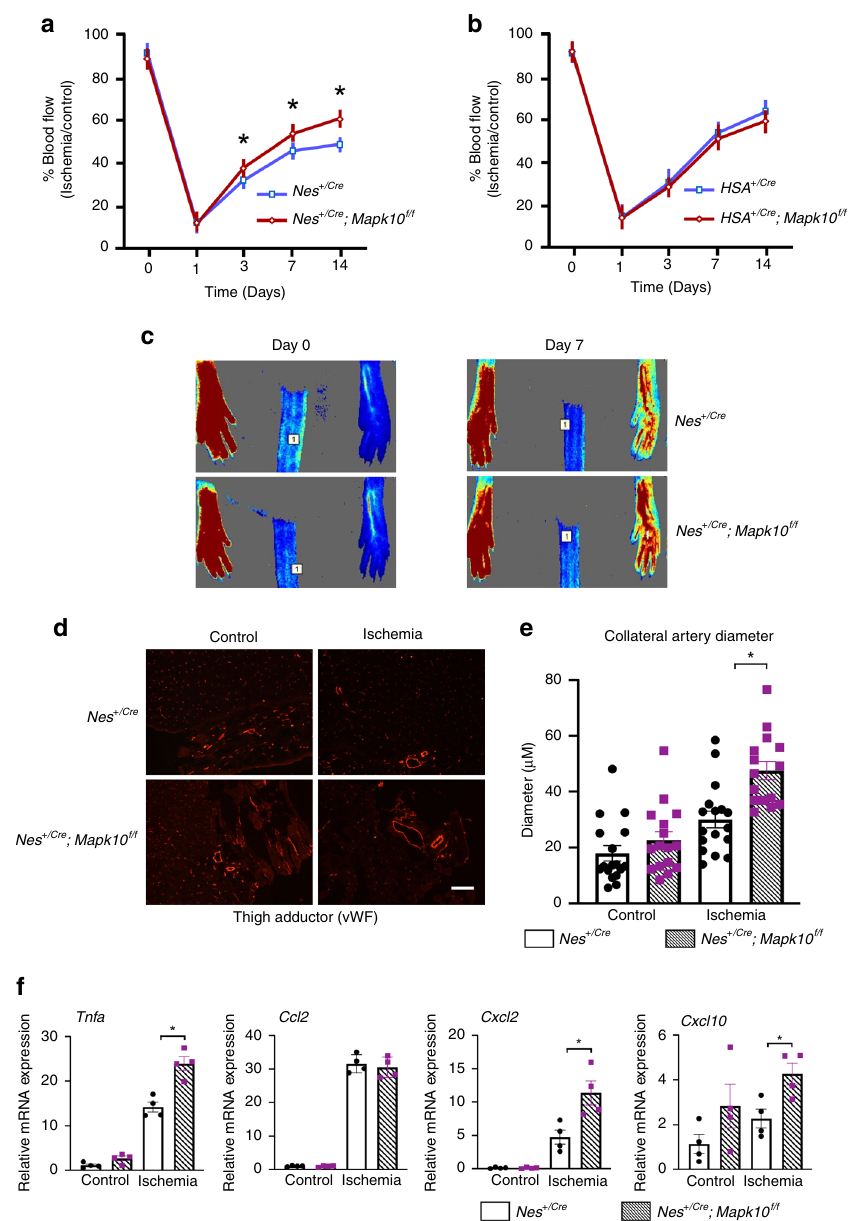
Fig. 2 Neural JNK3 plays an important role during blood fl ow recovery after hindlimb ischemia (HLI). Time course of blood fl ow recovery by laser speckle contrast imaging of neural-speci fi c nestin cre ( a ) and muscle-speci fi c HSA cre ( b ) Mapk10 − / − mice ( Nes + /Cre , n = 9; Nes + /Cre Mapk10 f/f , n = 8; HSA + /Cre , n = 8; HSA + /Cre Mapk10 f/f , n = 8). c Representative fi gures of blood fl ow measurements in the HLI model model on day 7 post HLI in Nes + /Cre and Nes + /Cre ; Mapk10 f/f mice. d Expression of von Willebrand factor (vWF) in mouse thigh adductor muscle on day 21 after femoral artery ligation. e Quanti fi cation of the diameter of collateral vessels, vWF, in mouse thigh adductor (TA) muscle on day 21 after femoral artery ligation ( Nes + /Cre control, n = 17; Nes + /Cre Mapk10 f/f , n = 16; Nes + /Cre ischemia, n = 17; Nes + /Cre Mapk10 f/f ischemia, n = 15). f qRT-PCR was performed for different genes related to collateral artery remodeling on thigh adductor muscle from the control and ischemic legs of WT and Nes + /Cre ; Mapk10 f/f mice 3 days post femoral artery ligation ( n = 4 in each group). All the experiments have been repeated 3 – 6 times. Statistically signi fi cant differences between groups are indicated (* P < 0.05 by Student ’ s t test). The data are mean ± SEM. Scale bar, 50 μ m. Source data are provided as a Source Data fi